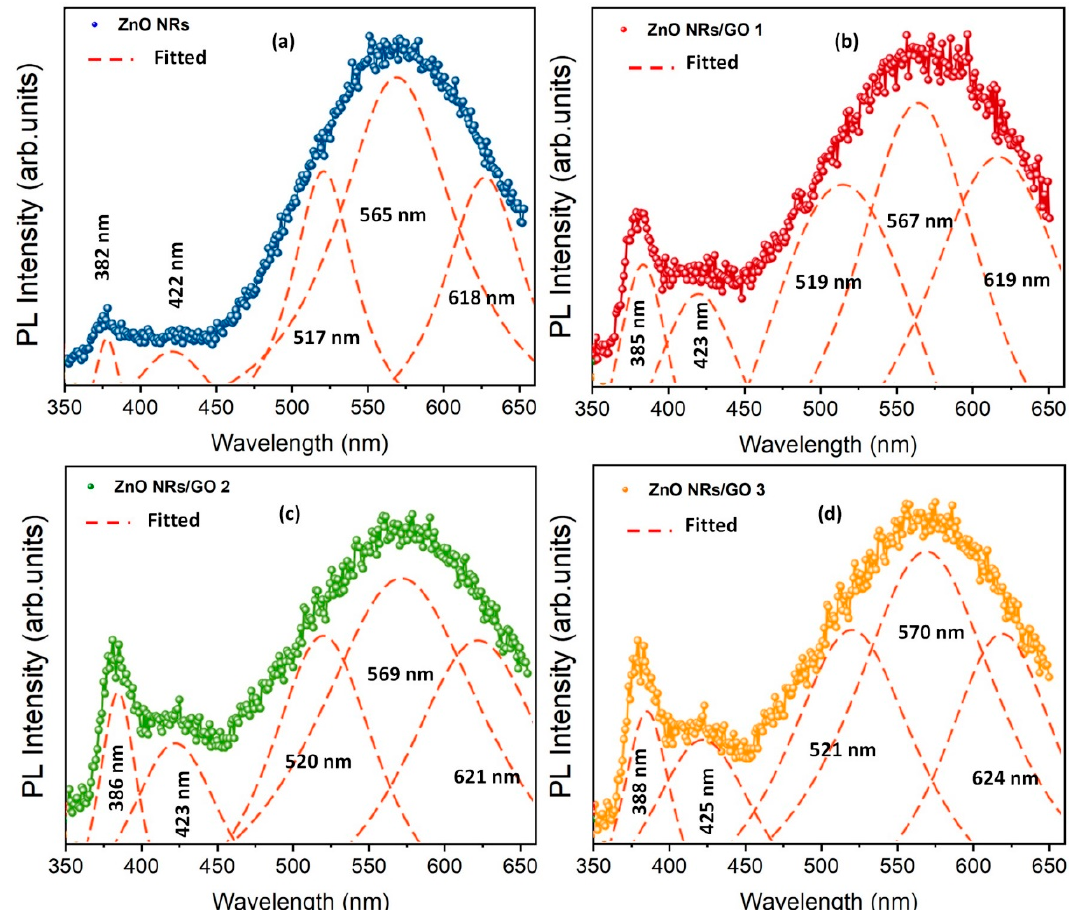
Figure 11. Gaussian line-shape fitting of the PL spectra of ( a ) ZnO NRs, ( b ) ZnO NR/GO1, ( c ) ZnO NR/GO2, and ( d ) ZnO NR/GO3 nanocomposites (solid and dashed lines represent the experimental and the fitted data, respectively).